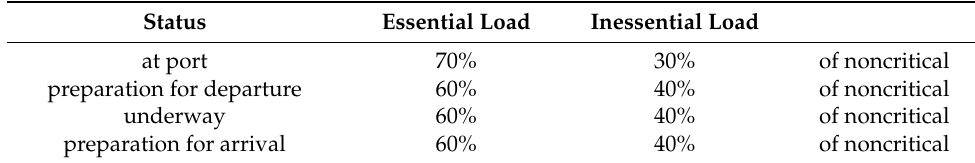
Table 5. Essential and inessential load division.